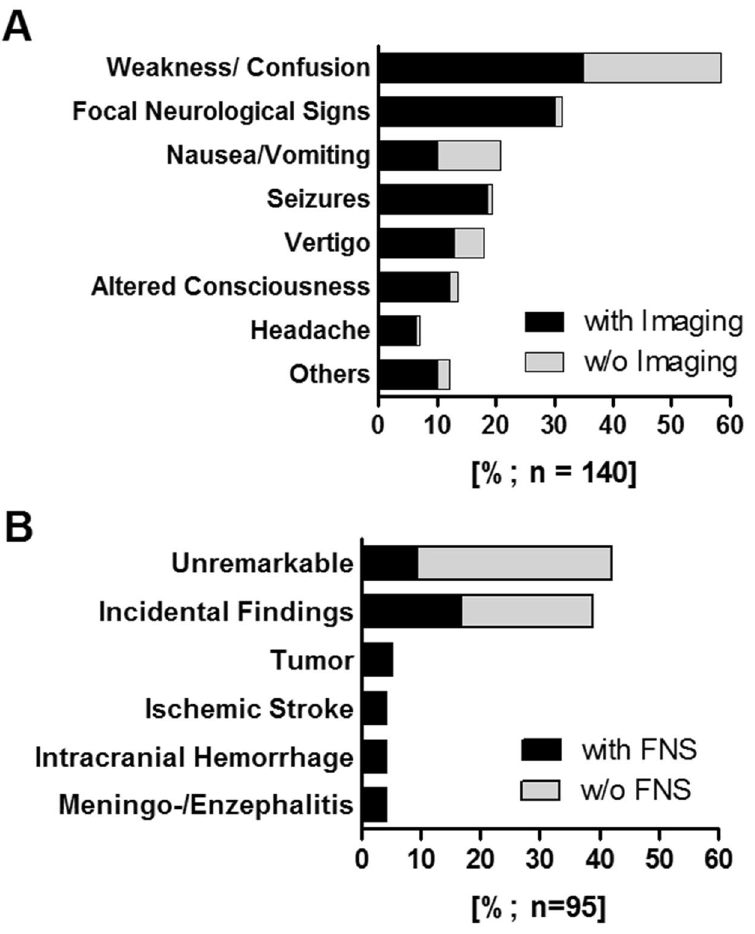
Figure 2. Neurological symptoms and imaging findings. ( A ) Prevalence of neurological symptoms ( focal neurological signs [FNS] and signs of global brain dysfunction ) in all patients with symptomatic hypotonic hyponatremia in our cohort (n = 140). ( B ) Results of neuroimaging studies (cCT and/or cMRI) in 95 of 140 patients (67.8%). Incidental findings (n = 38): imaging findings, which were not related to acute symptoms (multiple findings were permitted): general cerebral atrophy (n = 20), age-related periventricular white matter changes (n = 16), old ischemic stroke (n = 15), arteriosclerosis (n = 15), calcification of pineal gland/choroid plexus (n = 8), signs of former neurosurgical interventions (n = 3), signs of old fracture (n =